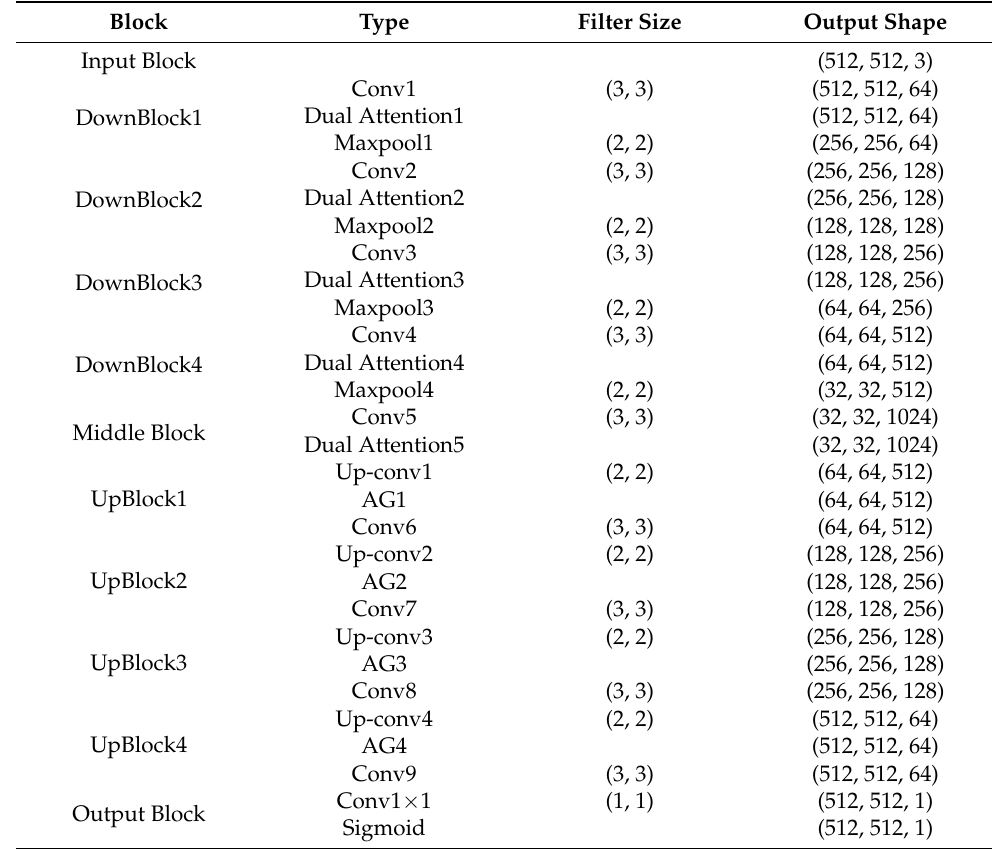
Table 2. Detailed parameters of the proposed model.